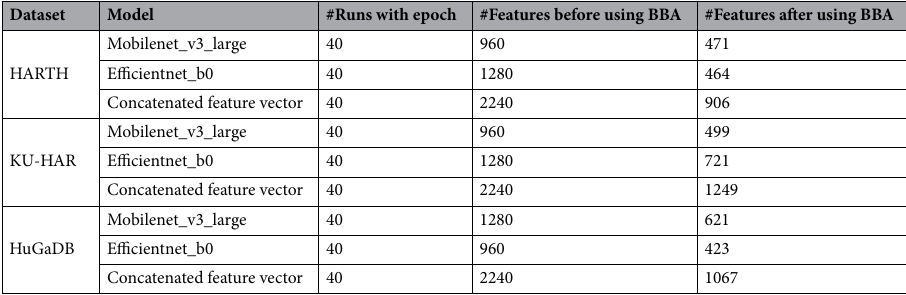
Table 5. Epoch size along with the number of features selected before and after applying BBA based feature selection method for all the three HAR